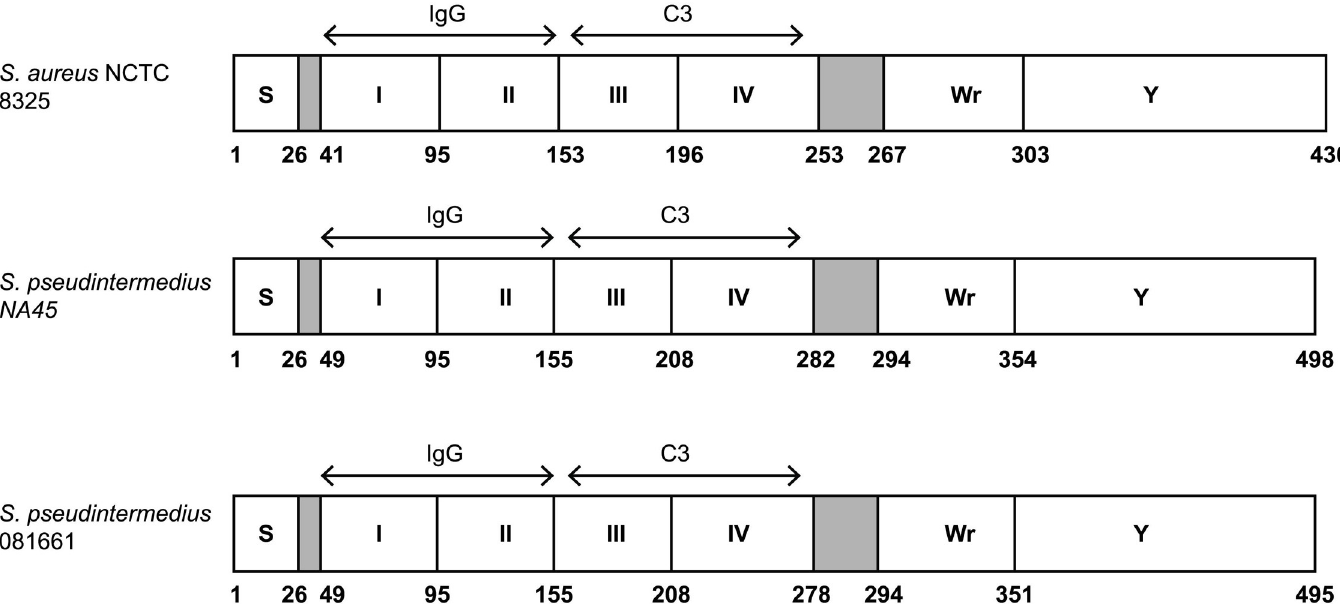
Fig 1. Schematic representation of S . pseudintermedius Sbi domains. The predicted structures of S . pseudintermedius Sbi proteins from strains NA45 and 081661 are depicted in comparison with S . aureus NCTC 8325 [11]. These include the signal peptides (S), N-terminal IgG-binding domains I and II (corresponding to S . aureus regions D1 and D2) and domains III and IV that correspond to complement C3 binding domains D3 and D4 of S . aureus [30]. These are followed by the Wr domain which is rich in proline and the Y domain that is tyrosine rich and likely involved in membrane binding [30]. Numbers correspond to amino acid residues.